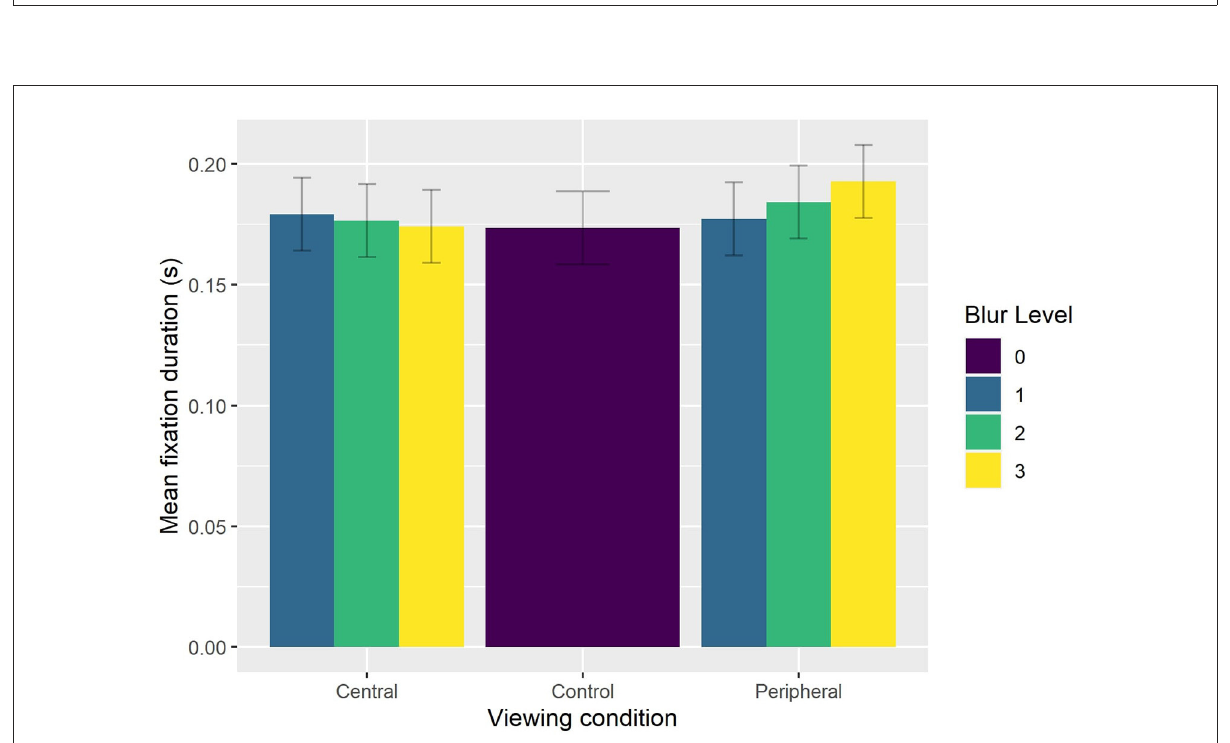
FIGURE6 Group mean fixation duration as a function of Viewing Condition and Blur